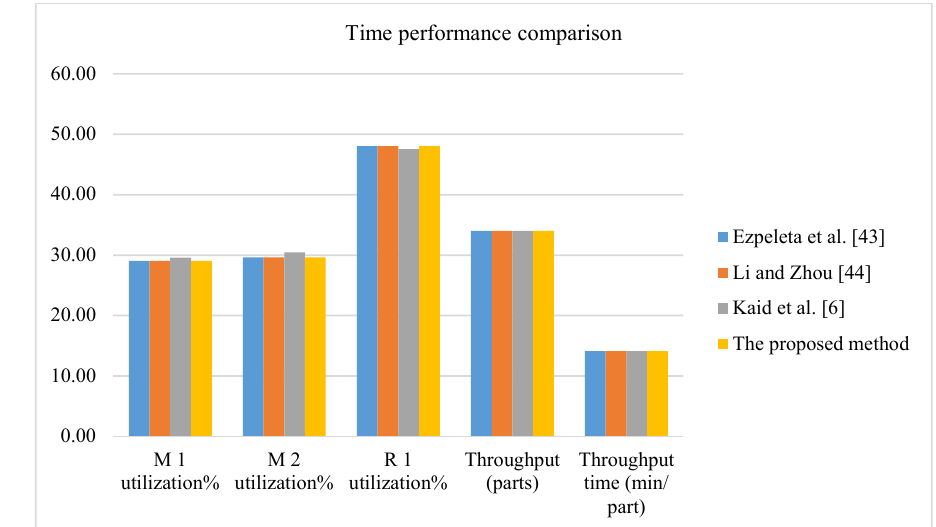
Figure 14. Comparison of the proposed method with the existing methods.